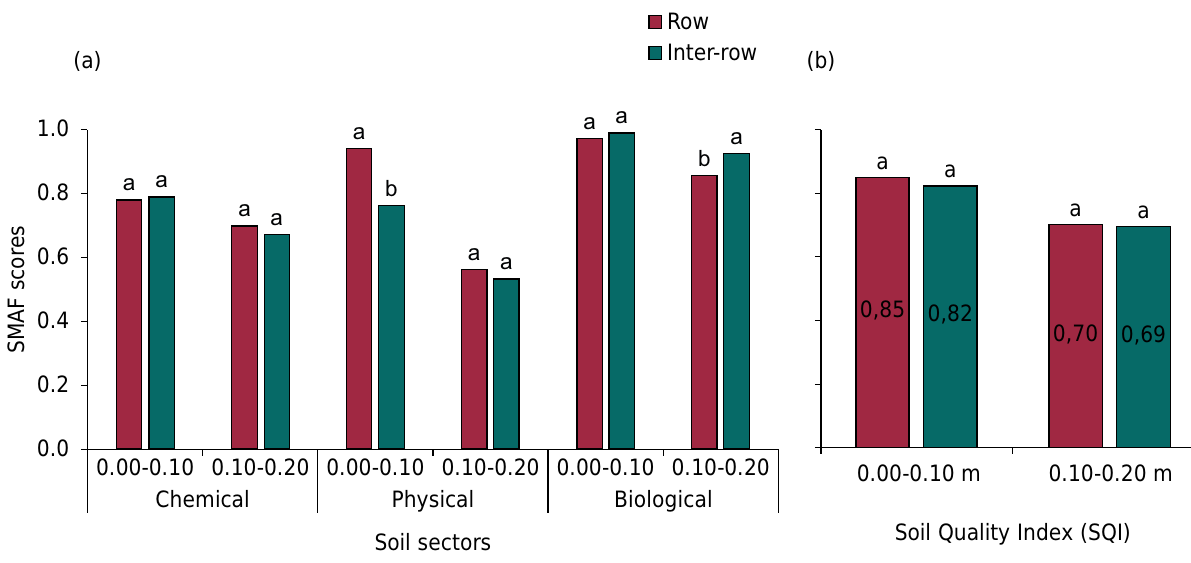
Figure 5. Soil sectors (chemical, physical, and biological) (a) and overall Soil Quality Index (SQI) (b) for the 0.00-0.10 and 0.10-0.20 m layers in the in-row and inter-row positions under a long-term no-tillage area. ‡ Mean scores within each depth and sector or SQI followed by the same letter do not differ among themselves according to Tukey’s test (p<0.05).